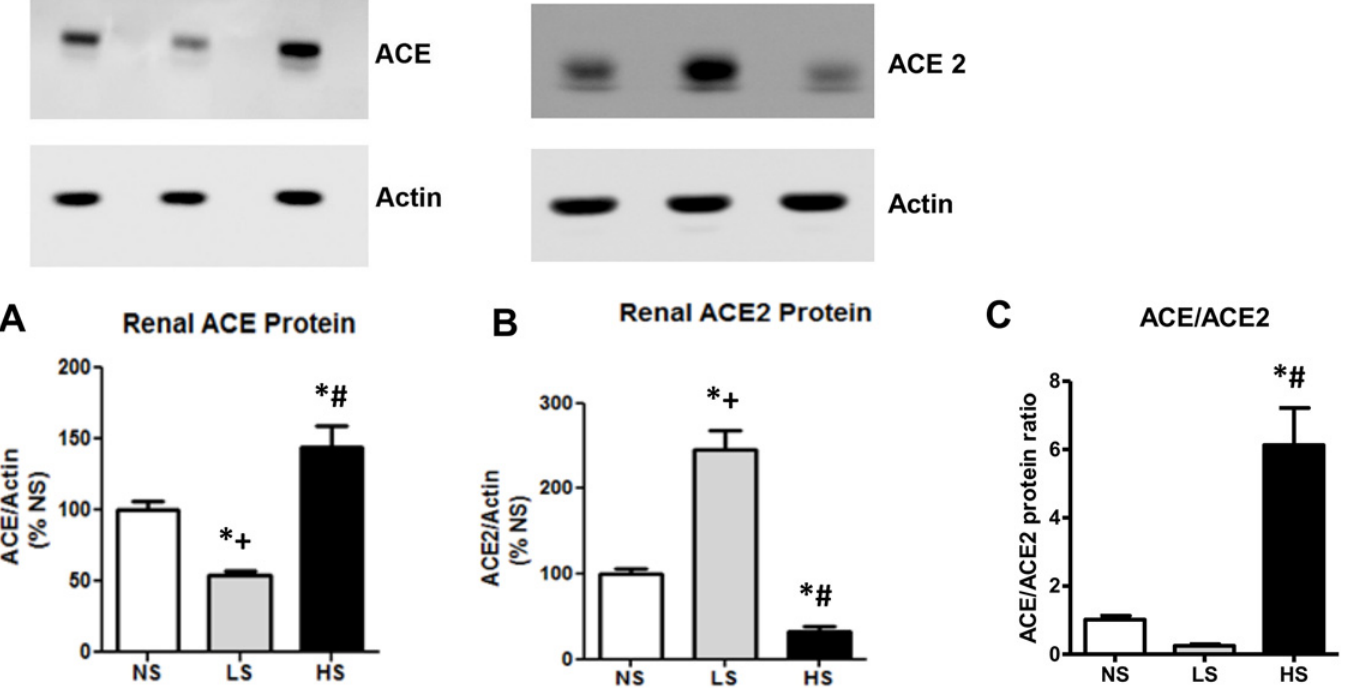
Fig 8. Analysis of ACE, ACE2 expression and ACE/ACE2 protein ratio. (A) ACE kidney expression. (B) ACE2 kidney expression. C: ACE/ACE2 protein ratio. Data are means ± SEM. NS: normal salt diet. LS: low salt diet. HS: high salt diet. * P < 0.05 vs. NS; + P < 0.05 vs. HS; # P < 0.05 vs LS.